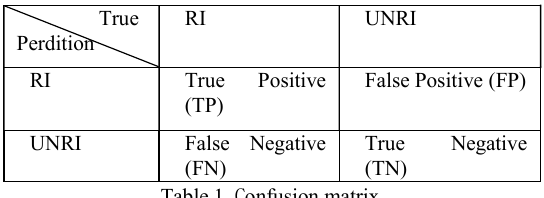
Table 1. C onfusion matrix.